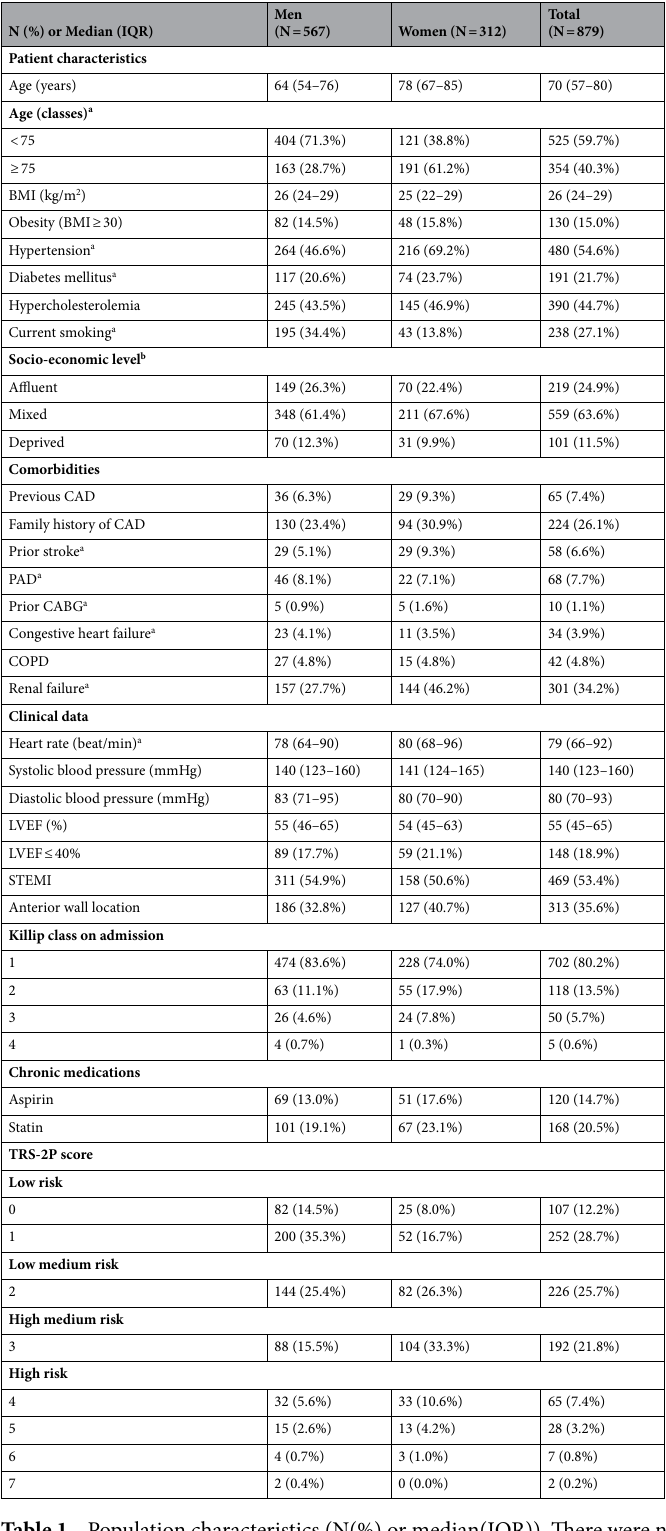
Table 1. Population characteristics (N(%) or median(IQR)). There were no significant differences in baseline characteristics between men and women. BMI body mass index, CABG coronary artery bypass graft, CAD coronary artery disease, COPD chronic obstructive pulmonary disease, IQR interquartile range, LVEF left ventricular ejection fraction, MI myocardial infarction, N number, PAD peripheral artery disease, STEMI ST-segment elevation myocardial infarction. a Items used to calculate the TRS-2P score (Thrombolysis in Myocardial Infarction Risk Score for Secondary Prevention). b Deprivation index